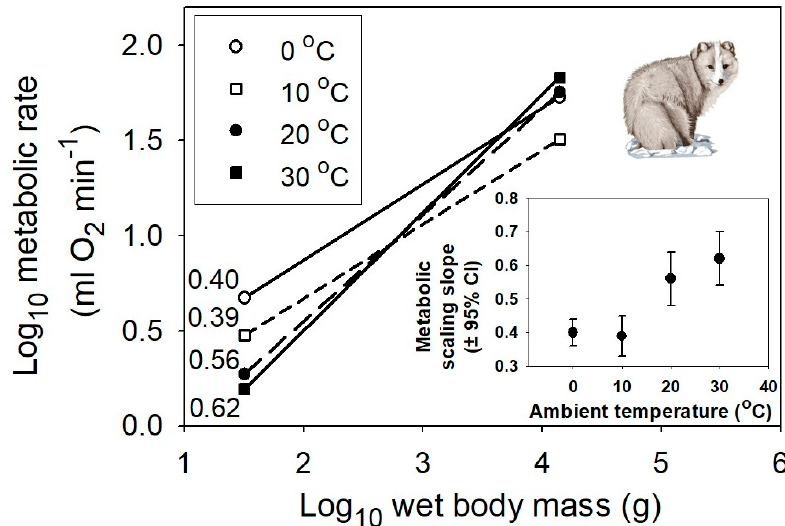
Figure 4. Interspecific scaling of metabolic rate in relation to body mass for multiple species of eutherian mammals at four different air temperatures, 0, 10, 20 and 30 °C (data from [58]). The correlation coefficients ( r ) and sample sizes ( n ) are 0.91 and 61, 0.84 and 69, 0.88 and 73, and 0.89 and 81, respectively. All probability values are <0.001. The inset graph shows the positive relationship between the metabolic scaling slope (±95% confidence intervals) and temperature. The mammal picture is from [59].